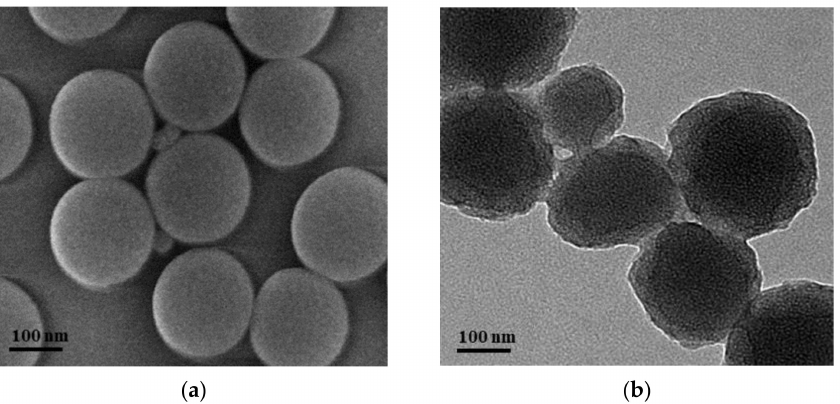
Figure 7. SEM image of SiO 2 nanoparticles ( a ), and TEM image of SiO 2 /P(MBAAm- co -AM) polymeric nanoparticles ( b ).